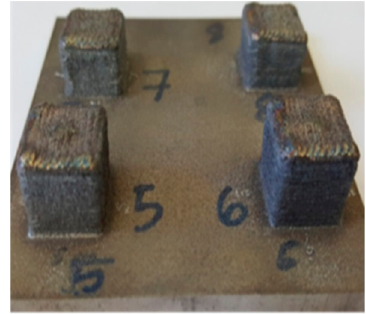
Figure 3. LENS in situ printed Ti–Al cubes.